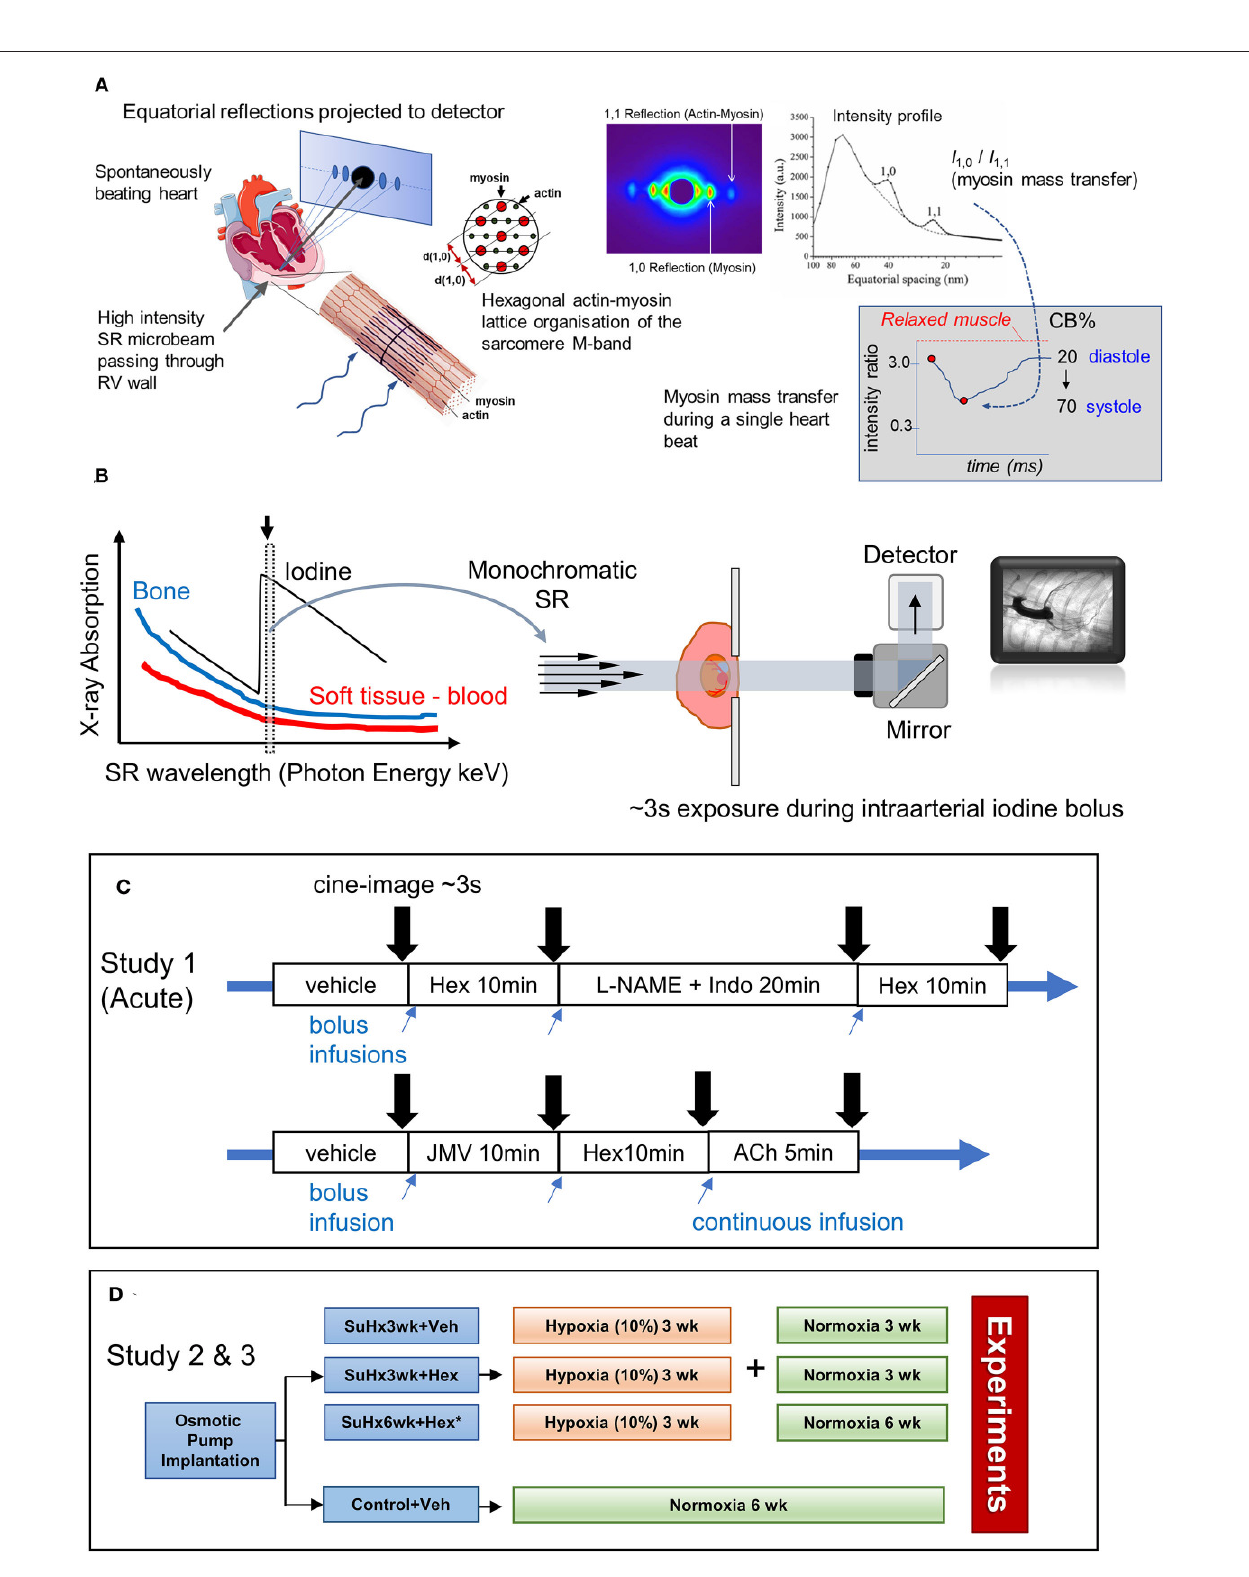
FIGURE 1 | Schematics illustrating the application of synchrotron radiation (SR)-based small-angle X-ray scattering (SAXS) to in situ beating hearts of anesthetized rodents, SR microangiography of the coronary circulation and protocols in studies 1–3. (A) Equatorial X-ray reflections are continuously recorded as scatter about the